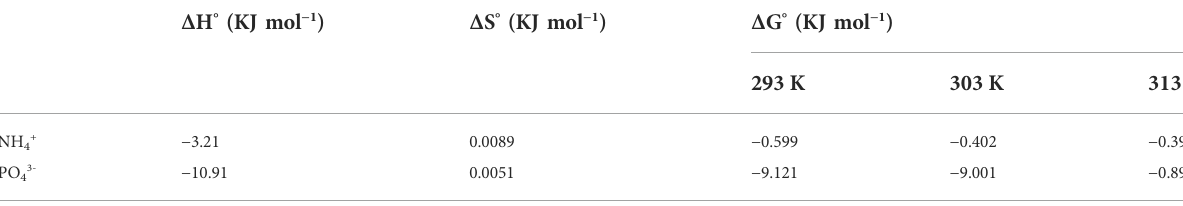
TABLE 3 Thermodynamic values for co-adsorption of phosphate and ammonium ions on TiO 2 /zeolite